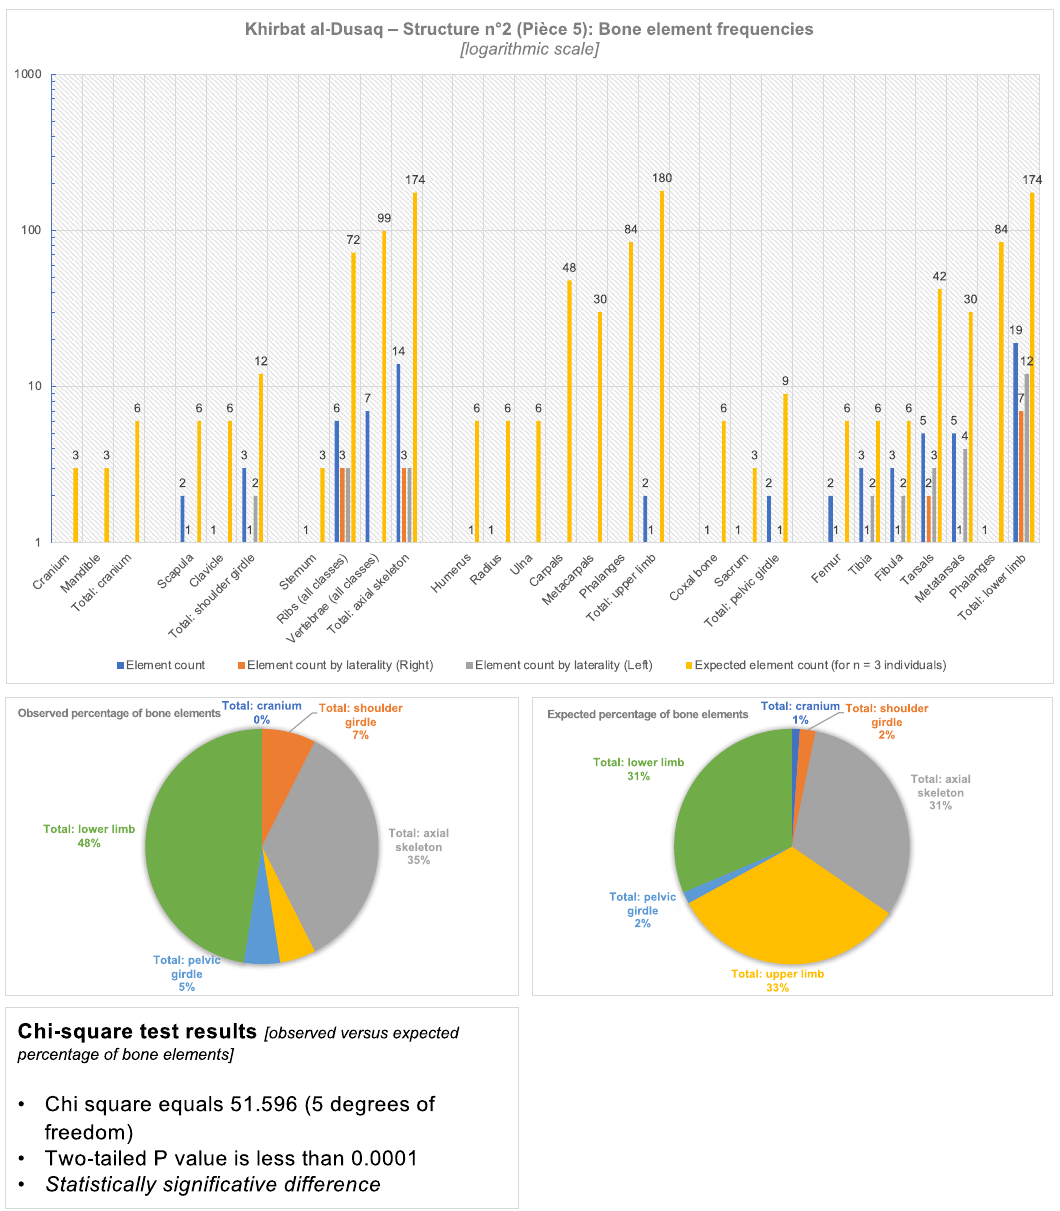
Figure 13: Structure no 2 ( Pièce 5 ) : bone element frequencies ( top ) and percentages ( bottom ) . Figures by Hofstetter ( 2022 )